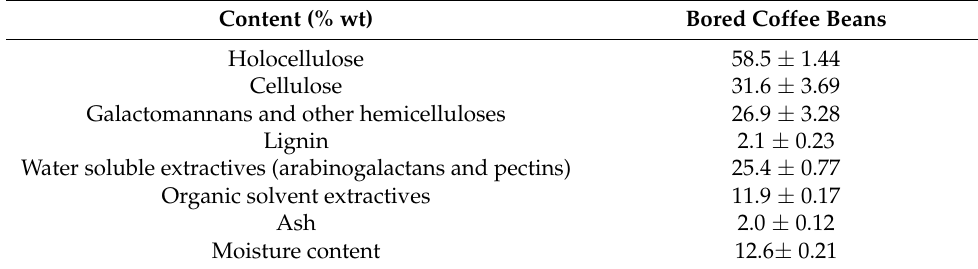
Table 1. Chemical composition of bored coffee beans (percentage on dry